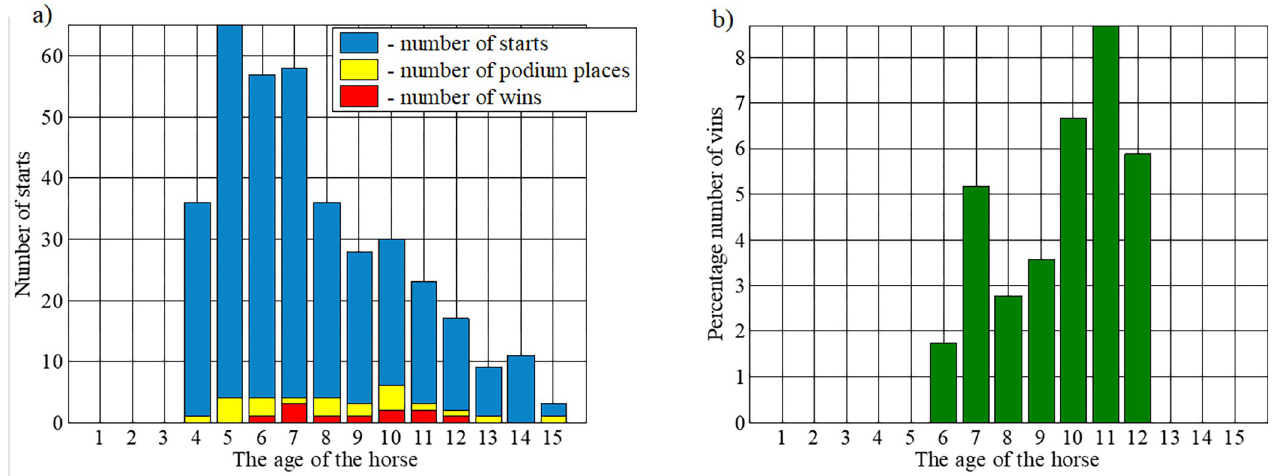
Fig 3. Number of horse victories according to their age. a) absolute values, b) percentage values.